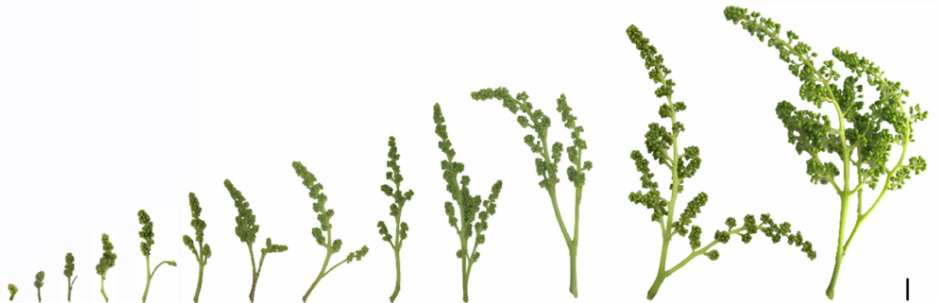
Figure 1. The lengths of ‘Xiangfei’ grape inflorescences used for sampling. From left to right: <1,